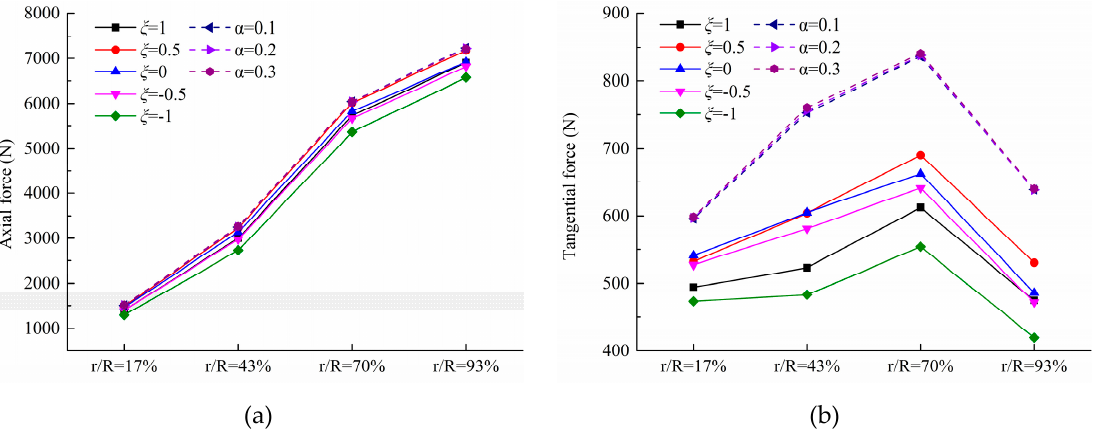
Figure 10. ( a ) Axial and ( b ) tangential force at different span-wise locations of the blade ( r / R = 17%, 43%, 70%, and 93%) under different inflow conditions.